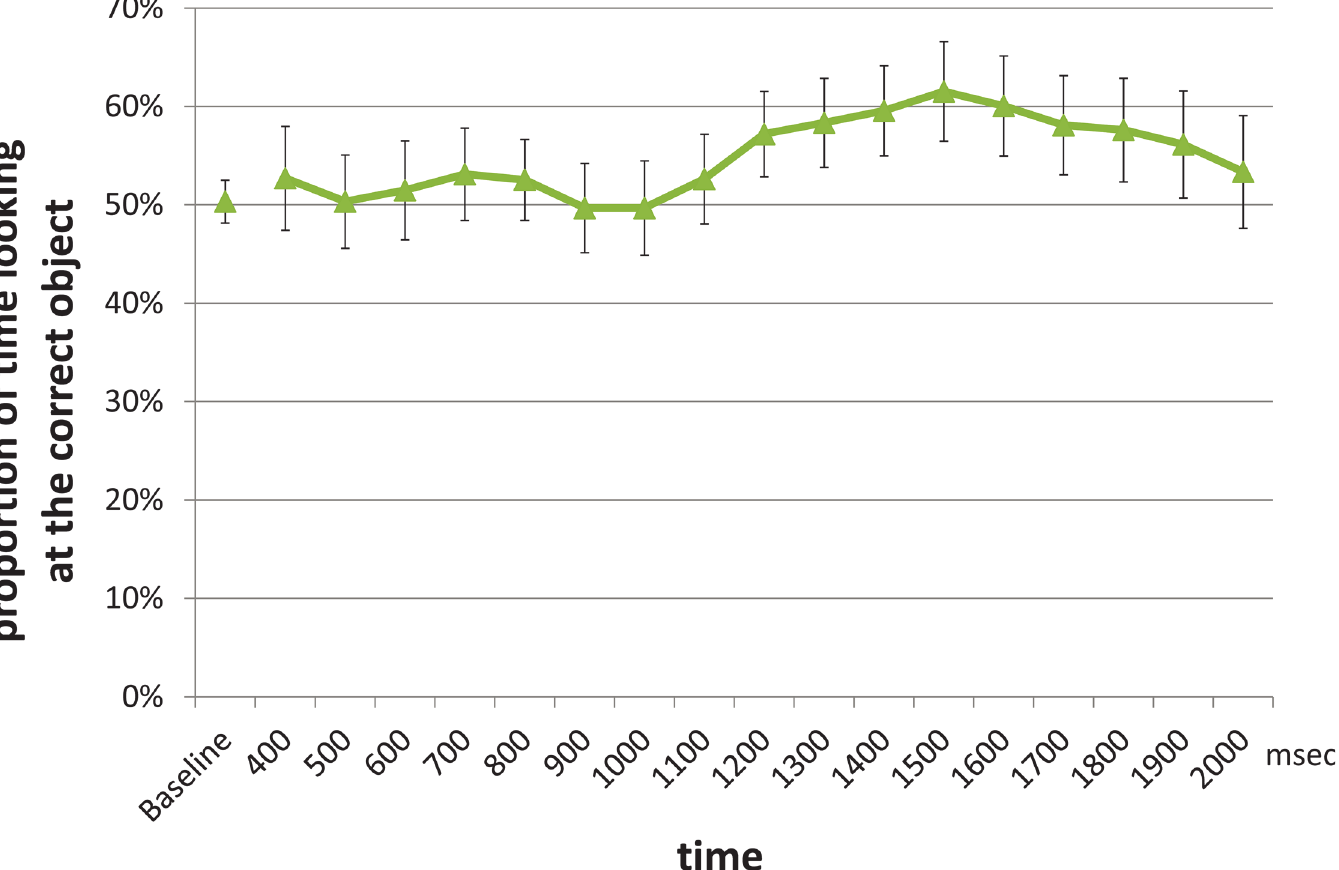
Fig 2. Mean proportion of time looking at the correct object in 100 ms intervals. In the filler trials match-mismatch combined. Baseline looking was calculated by averaging infants ’ looking at the target object 3000 ms immediately prior to the word onset. The error bar indicates standard